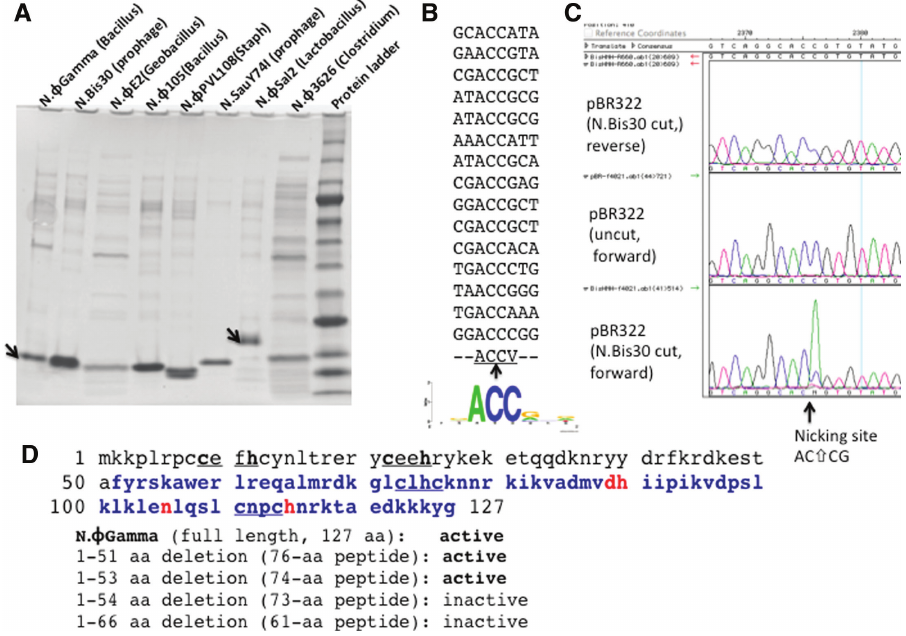
Figure 1: SDS-PAGE analysis of HNHEs, mapping of nicking sites for N.Bis30, and aa deletion analysis of N. φ